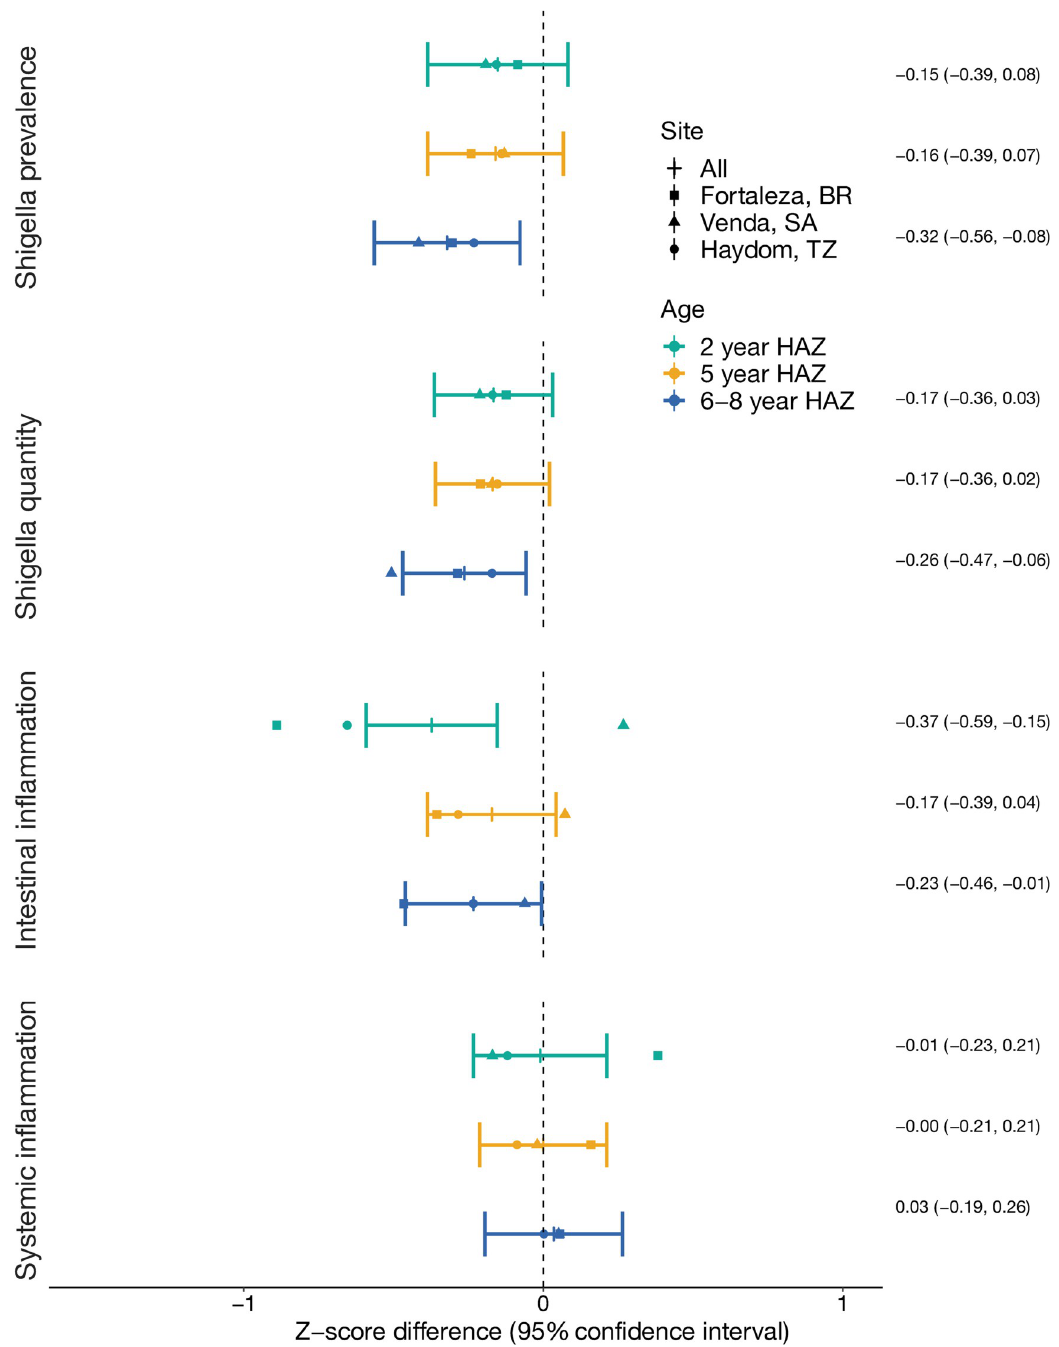
Fig 3. Associations between Shigella and inflammation in the first 2 years of life with linear growth at 2, 5, and 6–8 years of age among 451 children in the Brazil, South Africa, and Tanzania MAL-ED cohorts. Mean Z-score difference estimates and 95% confidence intervals were derived from linear regression models adjusting for site, enrollment length-for-age z-score, sex, socioeconomic status, exclusive breastfeeding in the first 6 months, maternal height, and the burden of each of the 12 most prevalent pathogens identified in the first 2 years of life (excluding Shigella